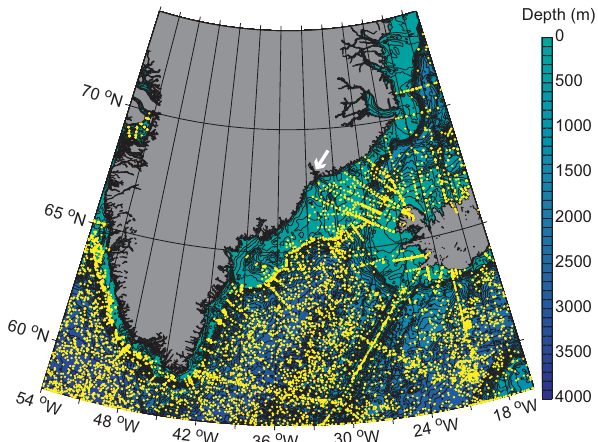
Fig. 2. Map of Greenland and the Irminger Sea with yellow dots showing location of in situ salinity and temperature measure- ments assimilated in the ocean reanalysis (see text for details). White arrow marks location of KFj and background colour shows bathymetry of the